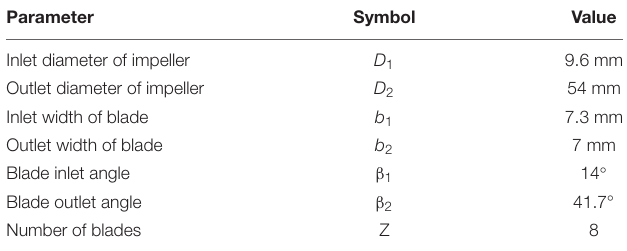
TABLE 1 | Design parameters of the pump impeller.